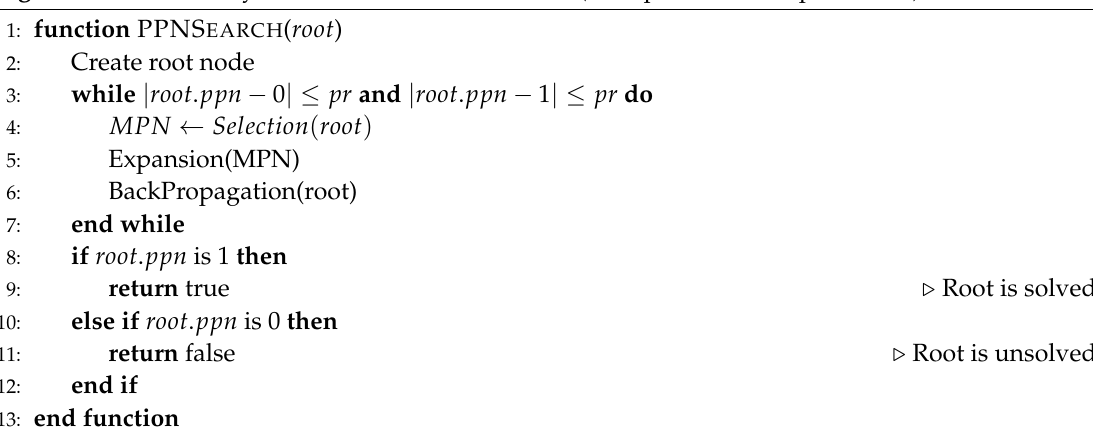
Algorithm 6 Probability-based Proof Number Search (with precision rate